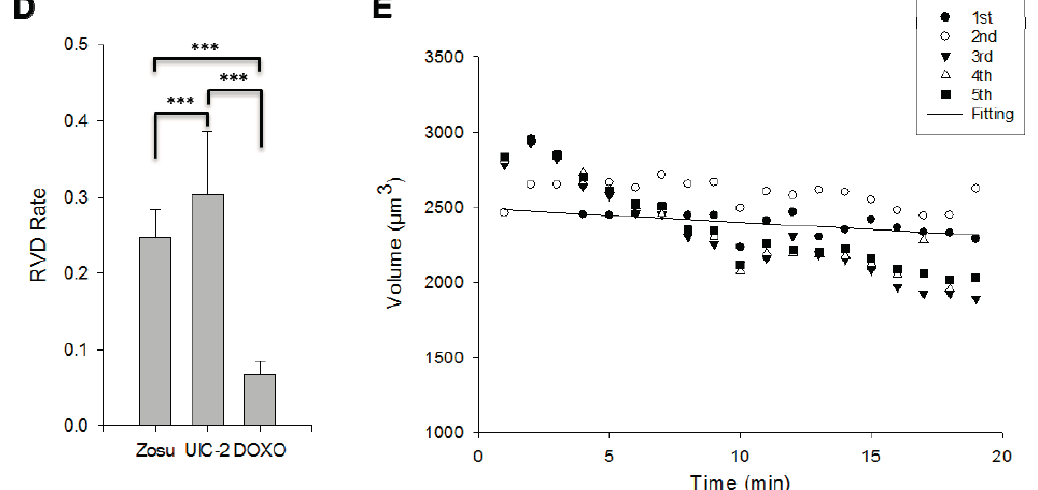
Figure 3. RVD in MCF7/Doxo is dependent on the P-gp activity. ( A ) P-gp activity. P-gp activity was followed with calcein-AM as a fluorescent probe. In each flow cytometry measurement, a sample of 10,000 cells was analyzed. Superimposed all-events histograms of calcein fluorescence distribution (log scale) in control MCF-7/Doxo cells ( left plot) and MCF-7/Doxo pre-incubated with the P-gp antagonist zosuquidar and UIC2 (10 μ M, middle plots) or with doxorubicin ( right histogram); ( B ) Cell volume monitoring of MCF7/Doxo in presence of P-gp modulators; ( C ) The histogram represents the mean of the cell volume after 1 or 7 min of 50% hypo-osmotic stress for the experiments presented in B . While under the control conditions (black) the cells retrieved their original volume after 7 min, the cells in presence of the P-gp modulators were not able to compensate their volume increase. Data are presented as mean ± SEM, *** p < 0.001.; ( D ) RVD rate of MCF7/Doxo cells in 50% hypo-osmotic shock (*** p < 0.001); and ( E ) Graphs show MCF7/Doxo cell volumes from five independent samples analyzed by flow cytometry after 50% hypo-osmotic conditions in the presence of doxorubicin. The data were fitted with Sigma